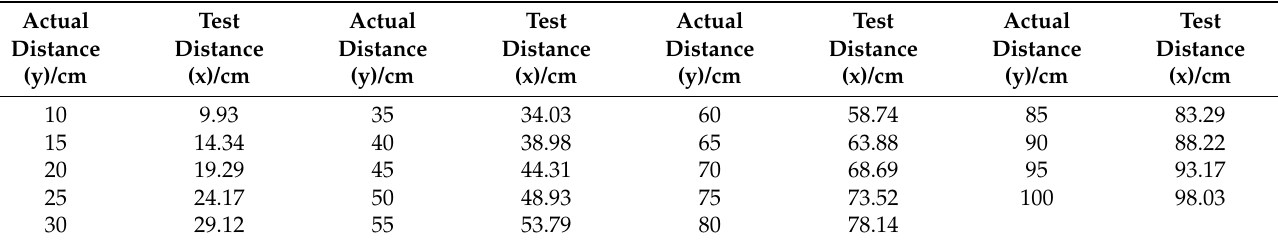
Table 3. Actual Distance and test distance.